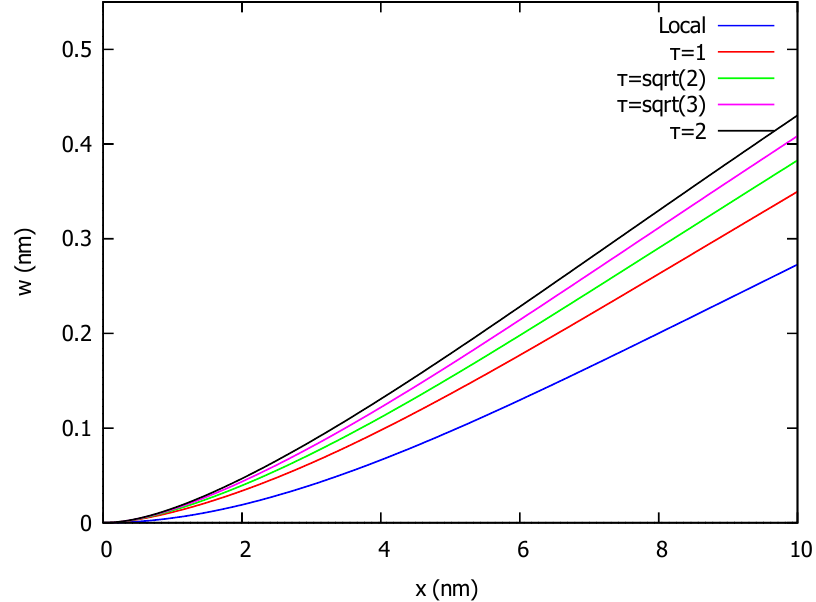
Figure 1. Deflection of cantilever beam (CF) under uniform load and various values of τ